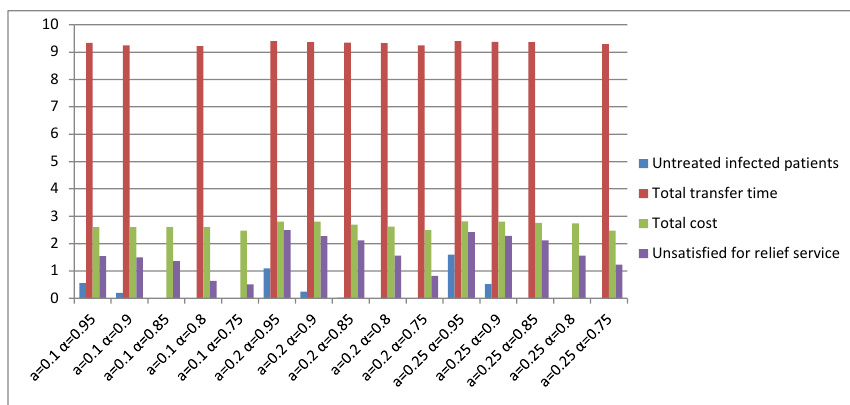
Figure 7. Results for a small test problem by the PICEA-g-AKNN algorithm.